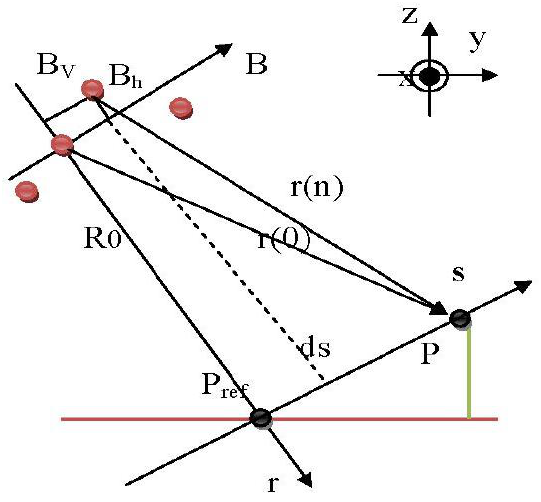
Figure 12. TomoSAR configuration. Pink circles are the positions of SAR, while black circles are points on the